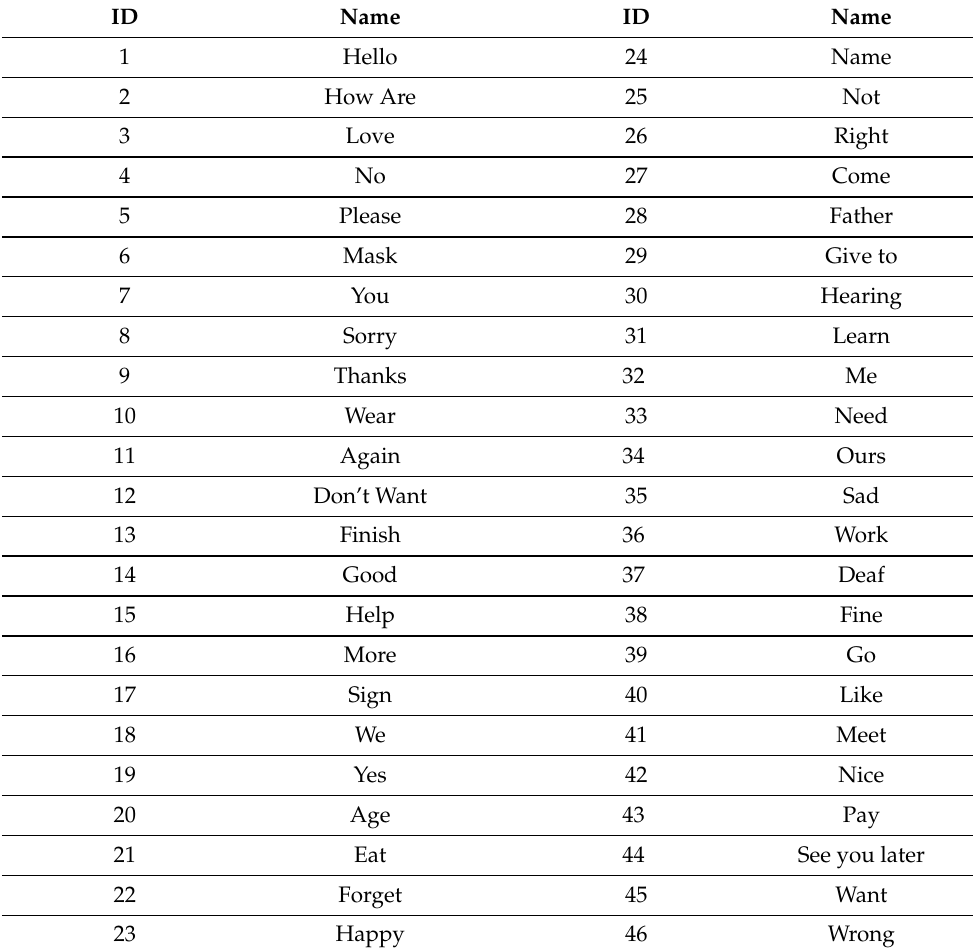
Table 4. DSL-46 dataset